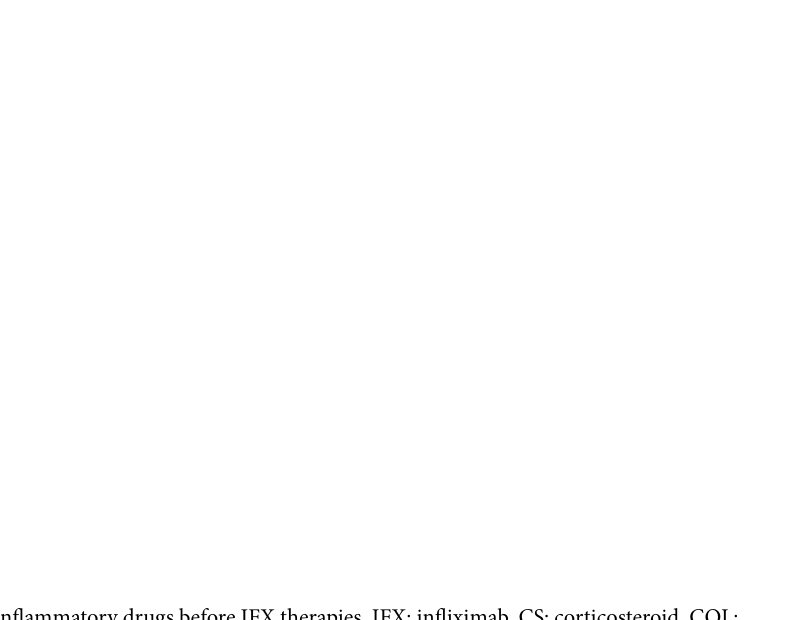
Table 2. Details of anti-inflammatory drugs before IFX therapies. IFX: infliximab, CS: corticosteroid, COL: colchicine, CsA: cyclosporin